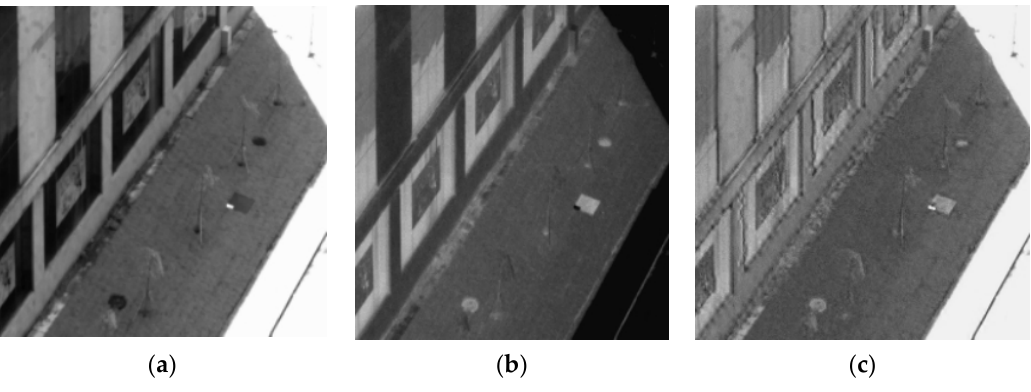
Figure 4. Simulation results. ( a ) S0 image; ( b ) DOP image; ( c ) fused image.